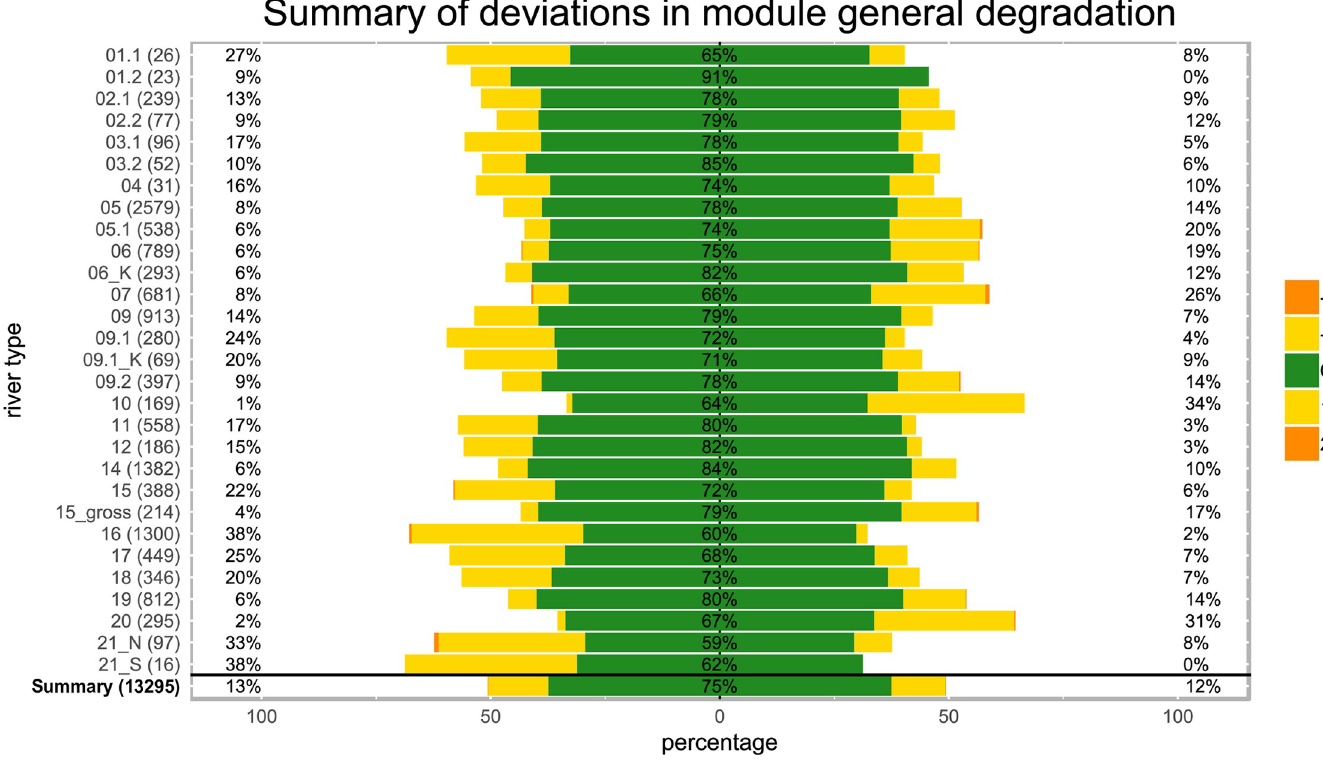
Fig 3. Deviations in general degradation module (GDM) results calculated from presence/absence data using ASTERICS for 13,295 samples from 30 German stream types (y-axis, numbers in parentheses = data points). Green indicates assessment values that remained identical, yellow indicates those that differed by ± 1 and orange indicates those that differed by ± 2 classes. Deviations in the negative (worse) direction are shown on the left and deviations towards a more positive assessment (better) are shown on the right